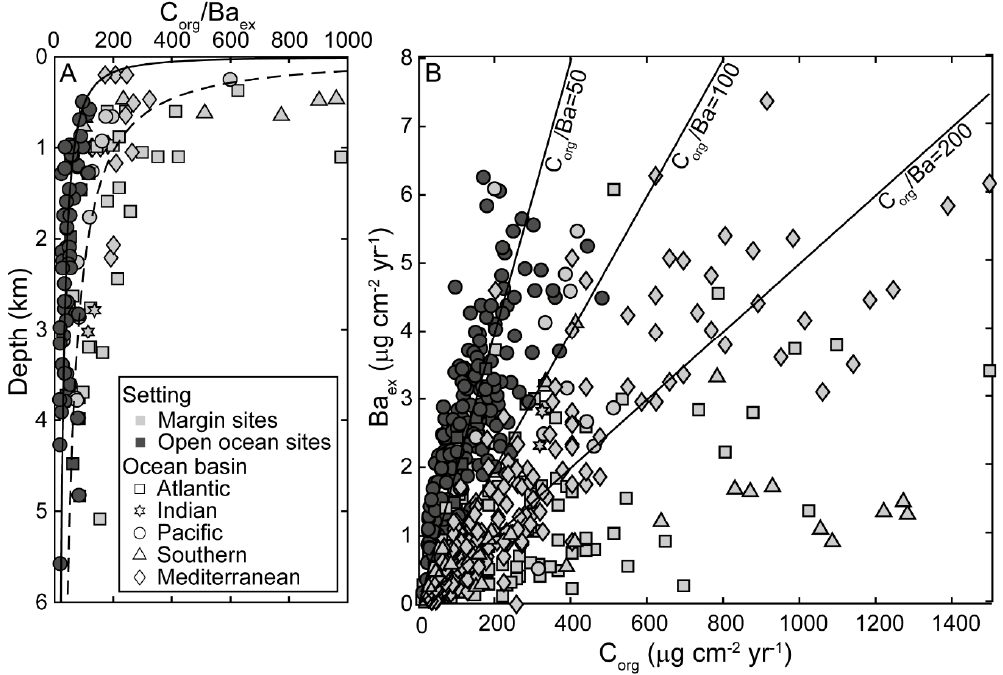
Figure 4. Sediment trap data from margin sites (light gray) and open ocean sites (dark gray). ( A ) Site averages of organic carbon:excess Ba (C org /Ba ex ) ratio versus depth, with different equations describing the relationship shown (solid-[40]; dashed-[111]). ( B ) Ba ex flux versus C org export. Different symbols denote different ocean basins, the Atlantic Ocean (squares) [11,40,111,116], the Indian Ocean (stars) [40], the Pacific Ocean (circles) [11,40,54], the Southern Ocean (triangles) [112,113], and the Mediterranean Sea (diamonds) [114,115].